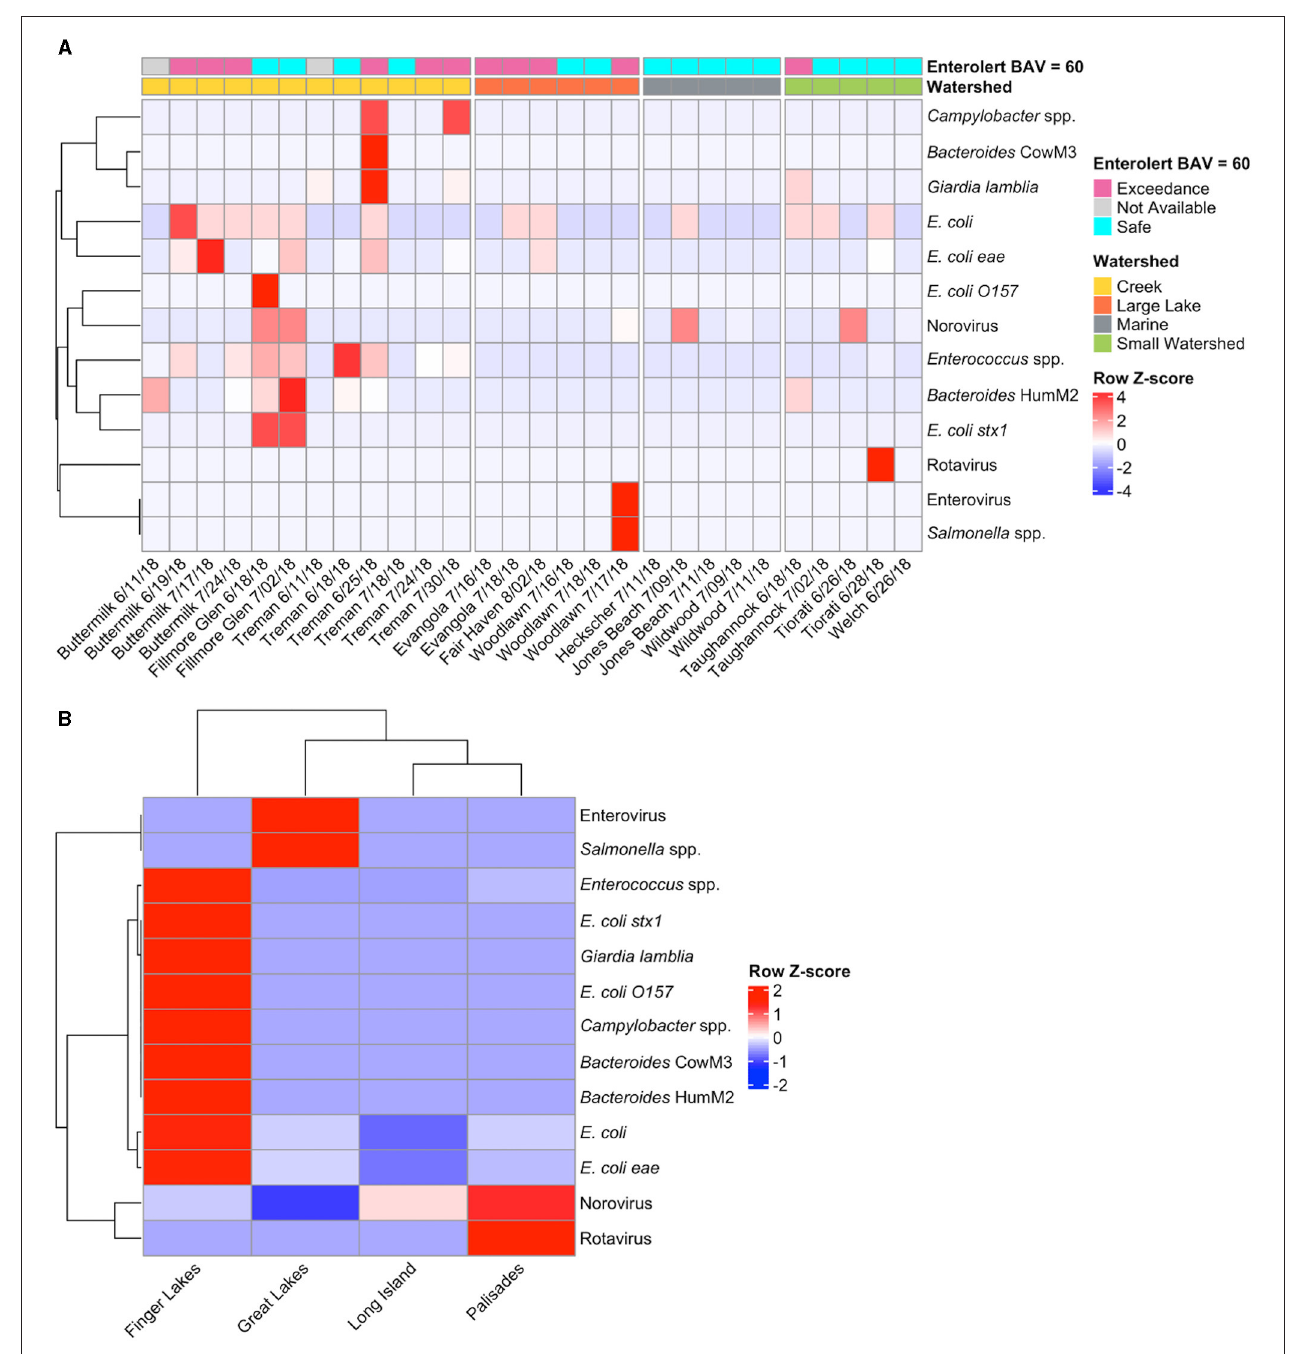
FIGURE 7 | Heat map of Pathogen Panel OpenArray-detected pathogens in the 2018 New York State beach morning samples for (A) individual samples by site and date and (B) samples grouped by region. For each sample, the watershed type (i.e., Creek, Large Lake, Marine, or Small Watershed) and the Enterolert results are shown. Samples were marked as “Safe” if Enterolert results were below a BAV of 60 MPN per 100ml; “Exceedance” if results exceeded this cutoff and the beach was closed; or “Not Available” if Enterolert results were unavailable at this site.